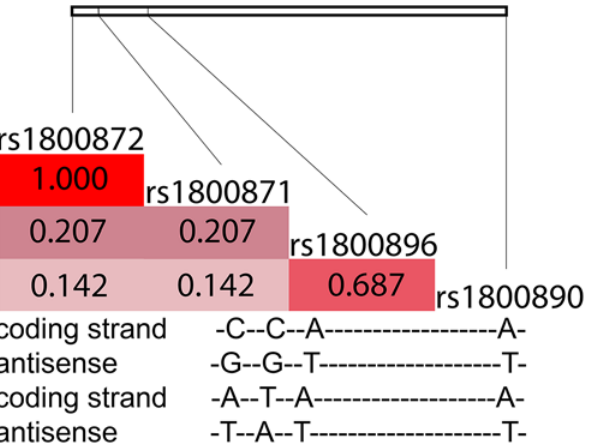
Fig 1. R 2 -values for the studied IL-10 polymorphisms in Finnish population based data. The formation of ACC(A)/ATA(A) genotype from the parental DNA strands described as an example . Colour = R 2 - correlation , all pairs D´ = 1 . Modified from